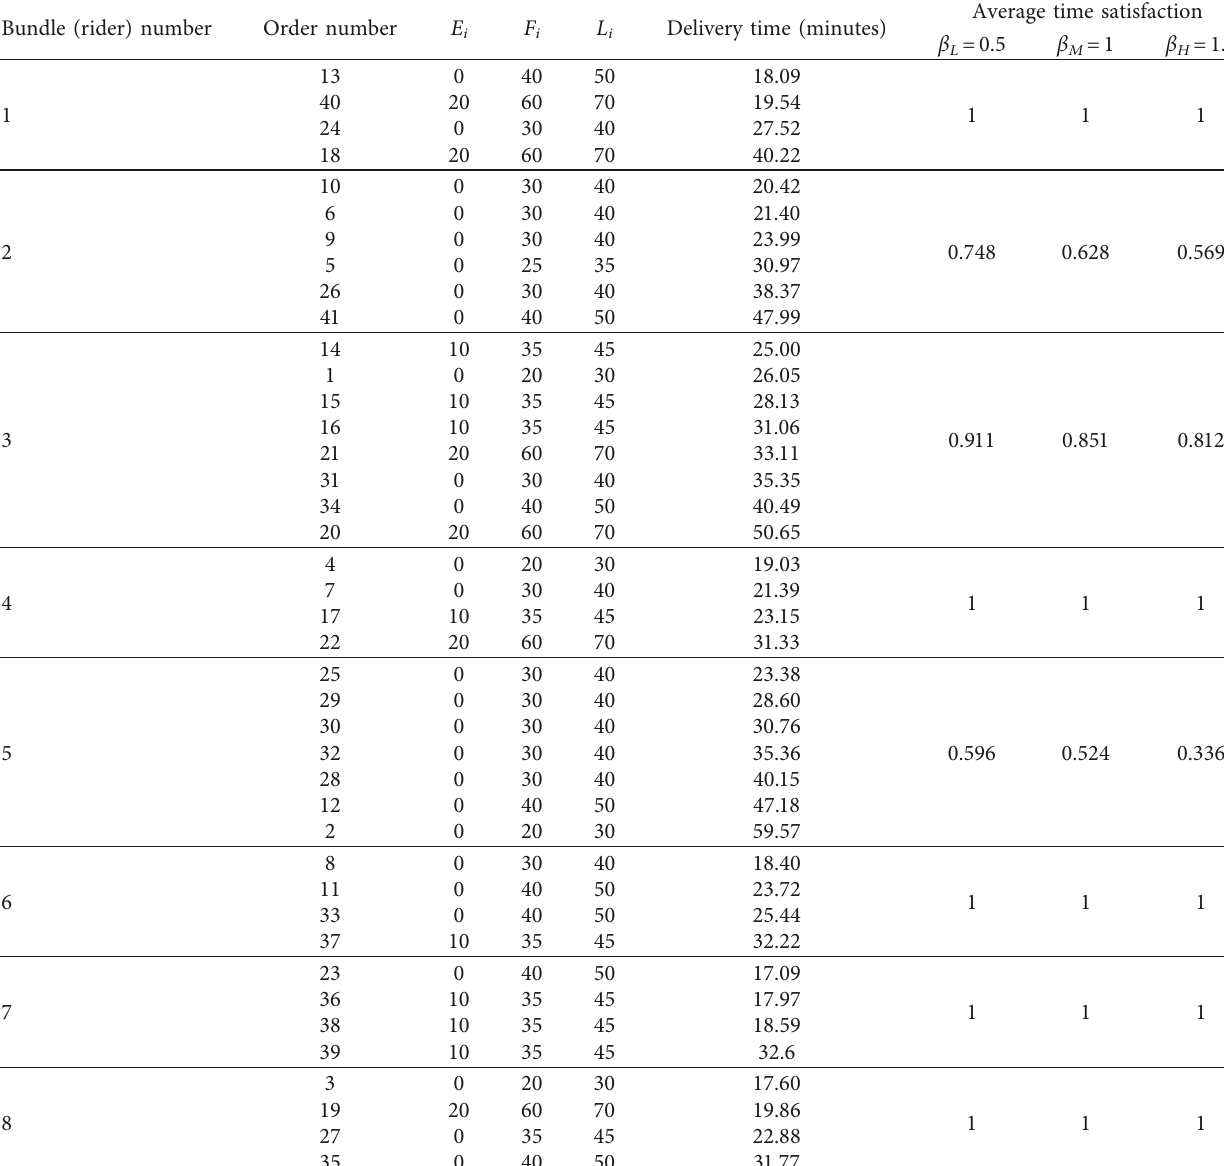
Table 4: Meal delivery time and average time satisfaction in clustered bundles.